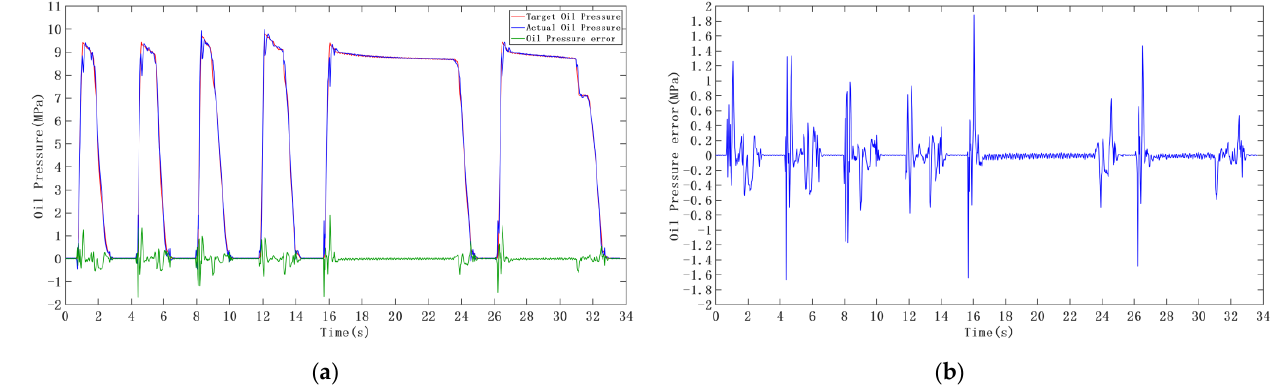
Figure 20. Results of oil pressure following control based on traditional PID controller under